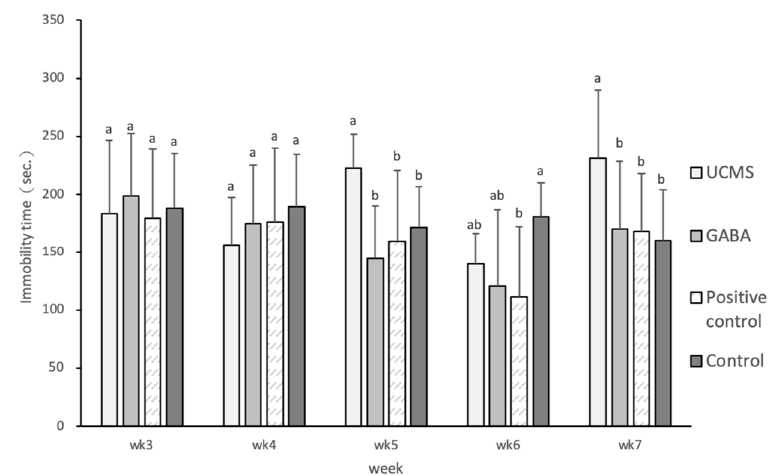
Figure 3. Effect of GABA feed by vegetable soybean on the immobility time of mice in tail suspension test (TST). Data are represented as mean ± SD. Group with different letter superscripts are significantly different ( p < 0.05).